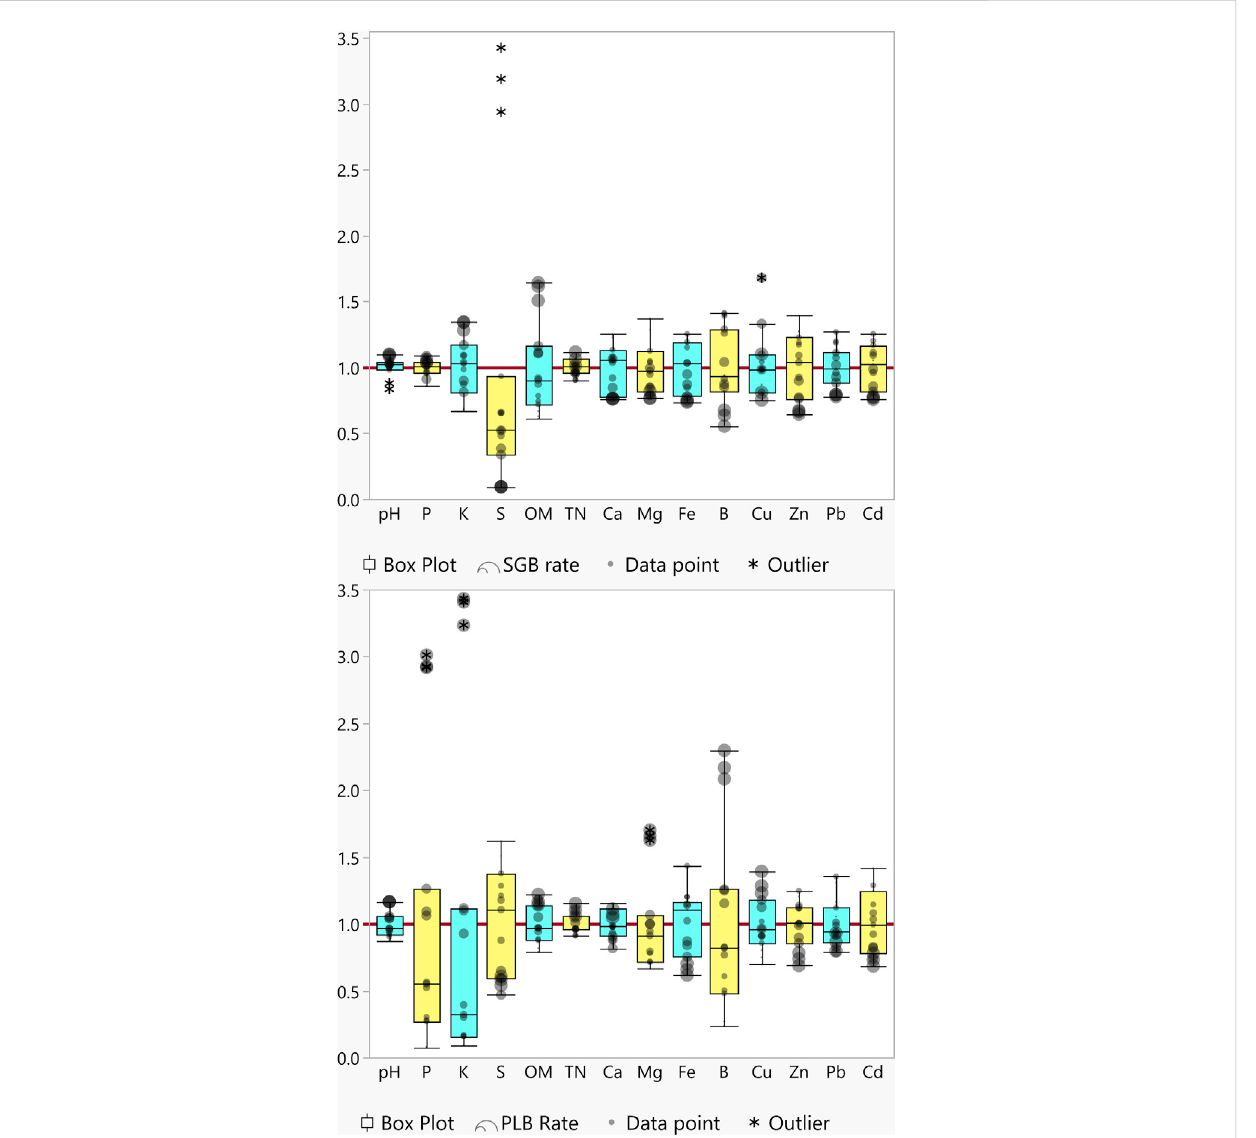
FIGURE 1 Boxplot of soil chemical attributes after switchgrass- and poultry litter-derived biochar application rates, SGB (top) and PLB (bottom). Data were normalized by dividing every measurement by the average of the whole dataset of measurements ( y-axis ). The Red line denotes the average. Boxes span the 25th to 75th data percentile, whiskers represent 1.5 × the interquartile range, and horizontal lines denote the